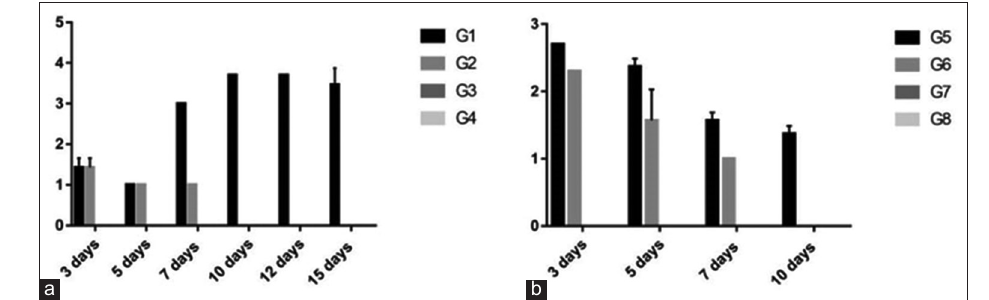
a b Figure-5: Column chart showing virus titration in egg from tracheal swabs (expressed as log 10) in different groups and different time conditions. (a) Experiment 1, (b) Experiment 2.